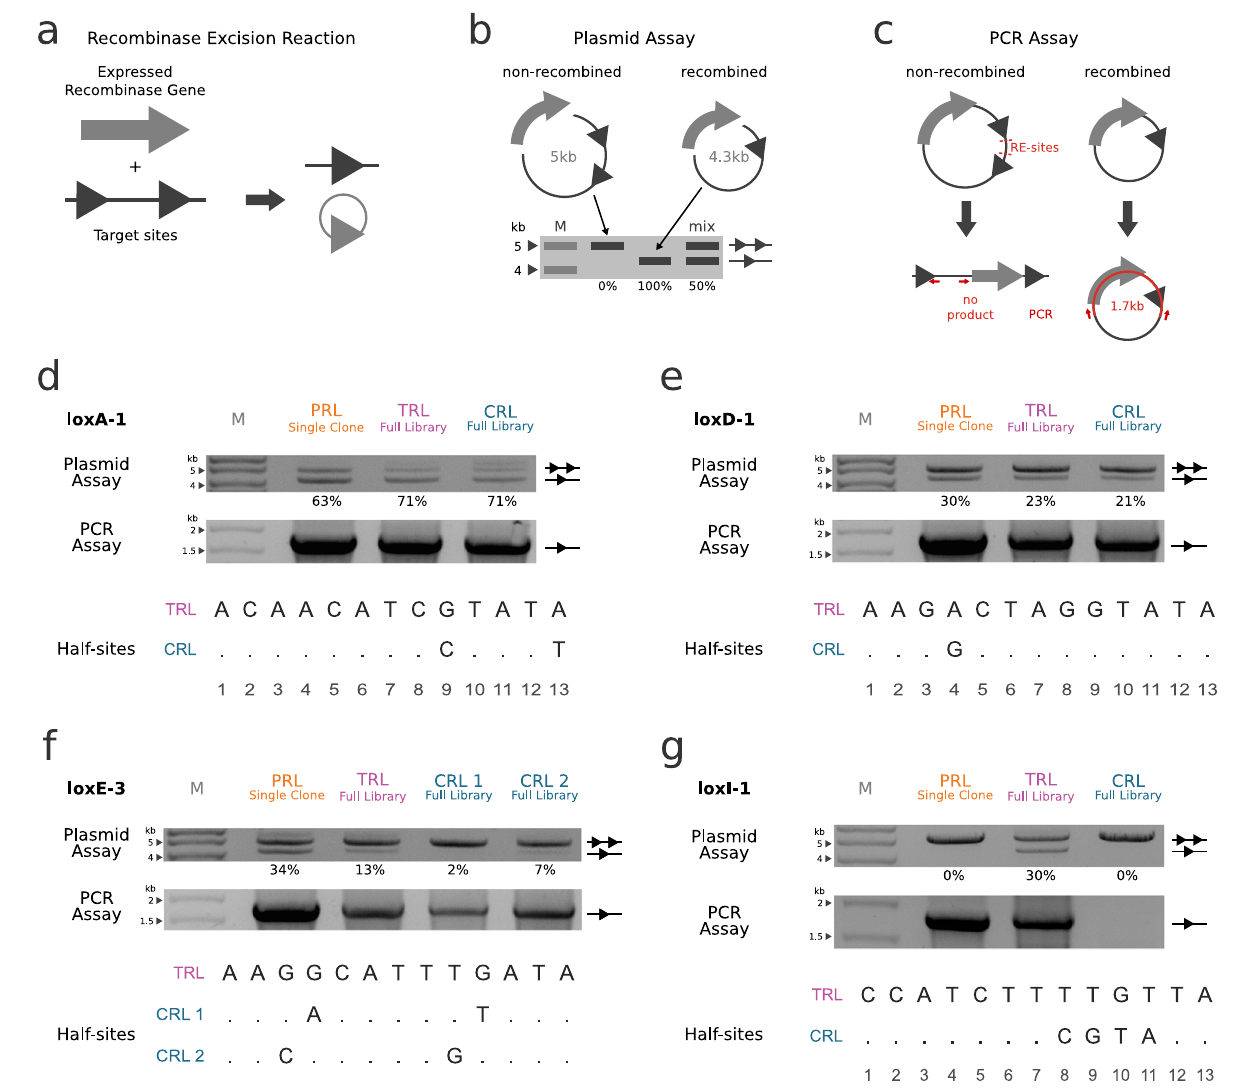
Fig. 3 | Experimental validation of RecGen leave-one-out cross-validation pre- dictions. a Illustration of recombinase gene expressionleading toexcision of DNA with two target sites. The target sites are represented as triangles, two triangles indicate non-recombined DNA, while one triangle indicates recombined DNA. The gray circle with one triangle represents the excised DNA that will be degraded by the cell. b Plasmid-based assay for recombination. Reporter plasmids cultured in bacteria cells that express recombinases which excise the DNA between target- sites. The modi fi cation leads to a difference of ~700bp in plasmid size, which can be detected via agarose gel electrophoresis. Recombined plasmid fragments are marked with a line and one triangle, non-recombined plasmid fragments are marked with a line and two triangles. “ M ” indicates the DNA Marker and “ mix ” is a representation of a mixture of recombined and non-recombined plasmid. Per- centagesbelowindicatetheamountofrecombinedplasmid. c PCR-basedassayfor